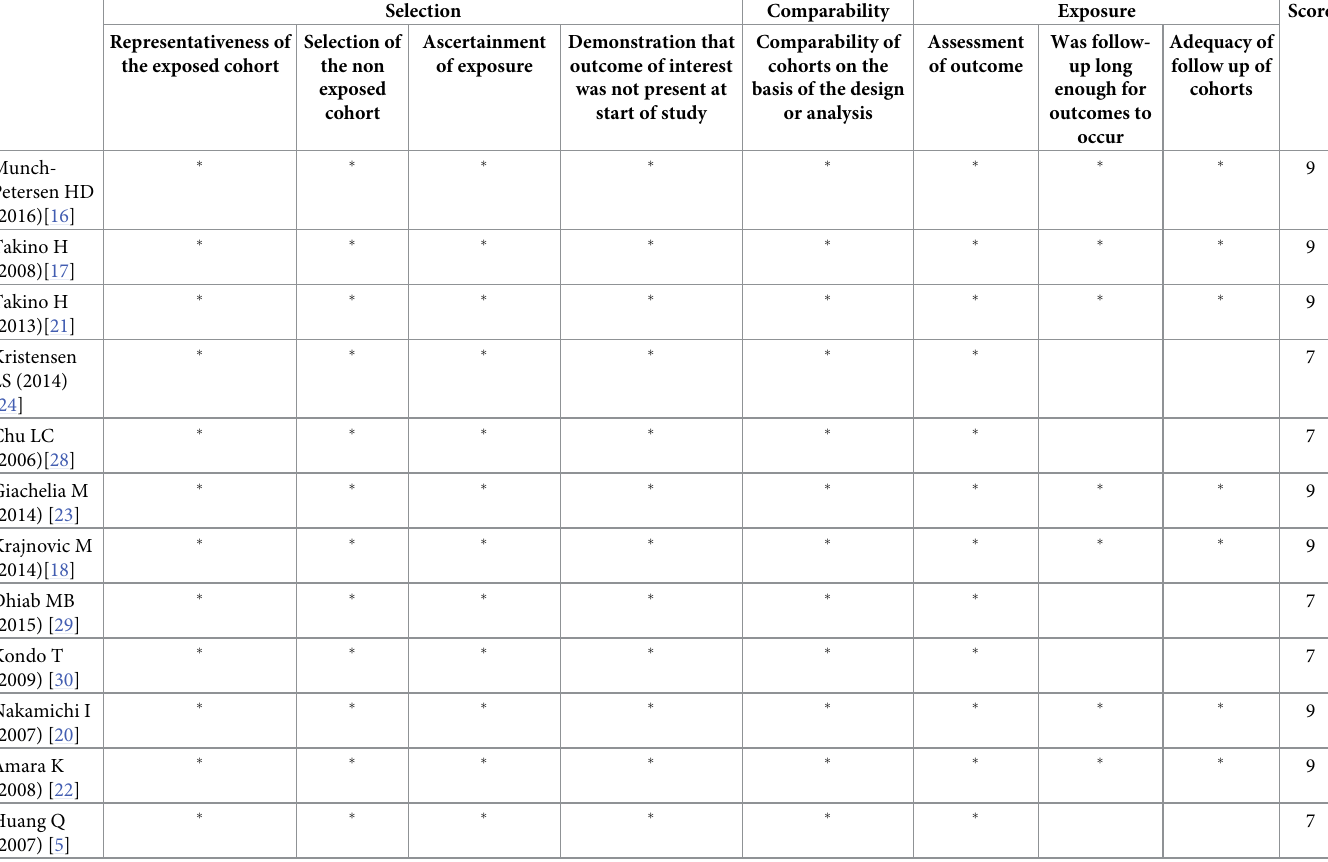
Table 2. Quality assessment of the observational studies based on the Newcastle-Ottawa